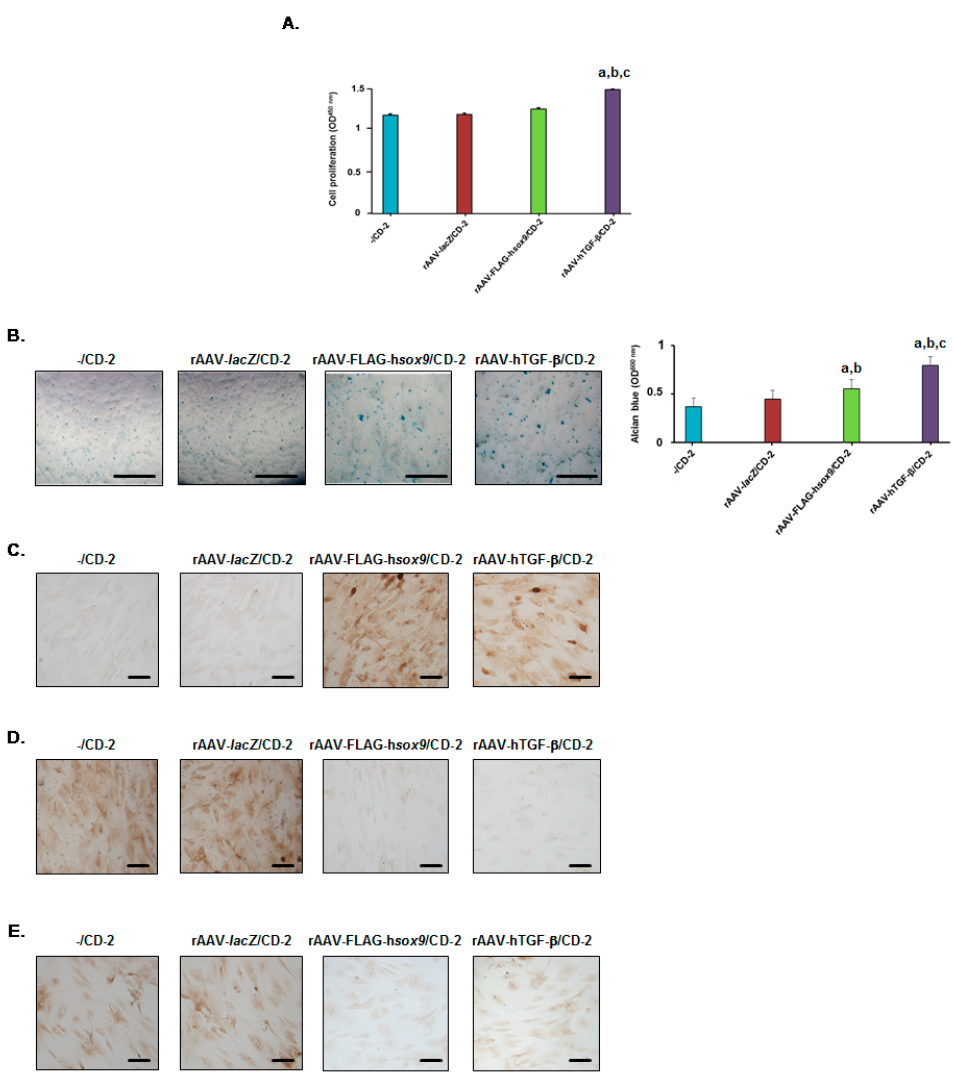
Figure 6. Biological activities in hMSCs transduced with the rAAV / CD-2 system. The rAAV-FLAG-h sox9 , rAAV-hTGF- β , and rAAV- lacZ vectors (40 µ L each vector, i.e., 8 × 10 5 transgene copies) were formulated with CD-2 (40 µ L), and the resulting rAAV / CD systems (80 µ L) were incubated with hMSCs (10,000 cells in 48-well plates; MOI = 80) for up to 21 days. Cell proliferation was examined using the Cell Proliferation Reagent WST-1 ( A ), glycosaminoglycans using alcian blue staining (light microscopy; magnification × 4; scale bars: 200 µ m; all representative data) with spectrophotometric analysis after solubilization (histograms) ( B ), and the deposition of type-II collagen ( C ), type-I collagen ( D ), and type-X collagen ( E ) using immunocytochemistry (magnification × 20; scale bars: 50 µ m; all representative data). rAAV- lacZ / CD-2 and CD-2 lacking rAAV were used as controls. Statistically significant relative to a - / CD-2, b rAAV- lacZ / CD-2, and c rAAV-FLAG-h sox9.